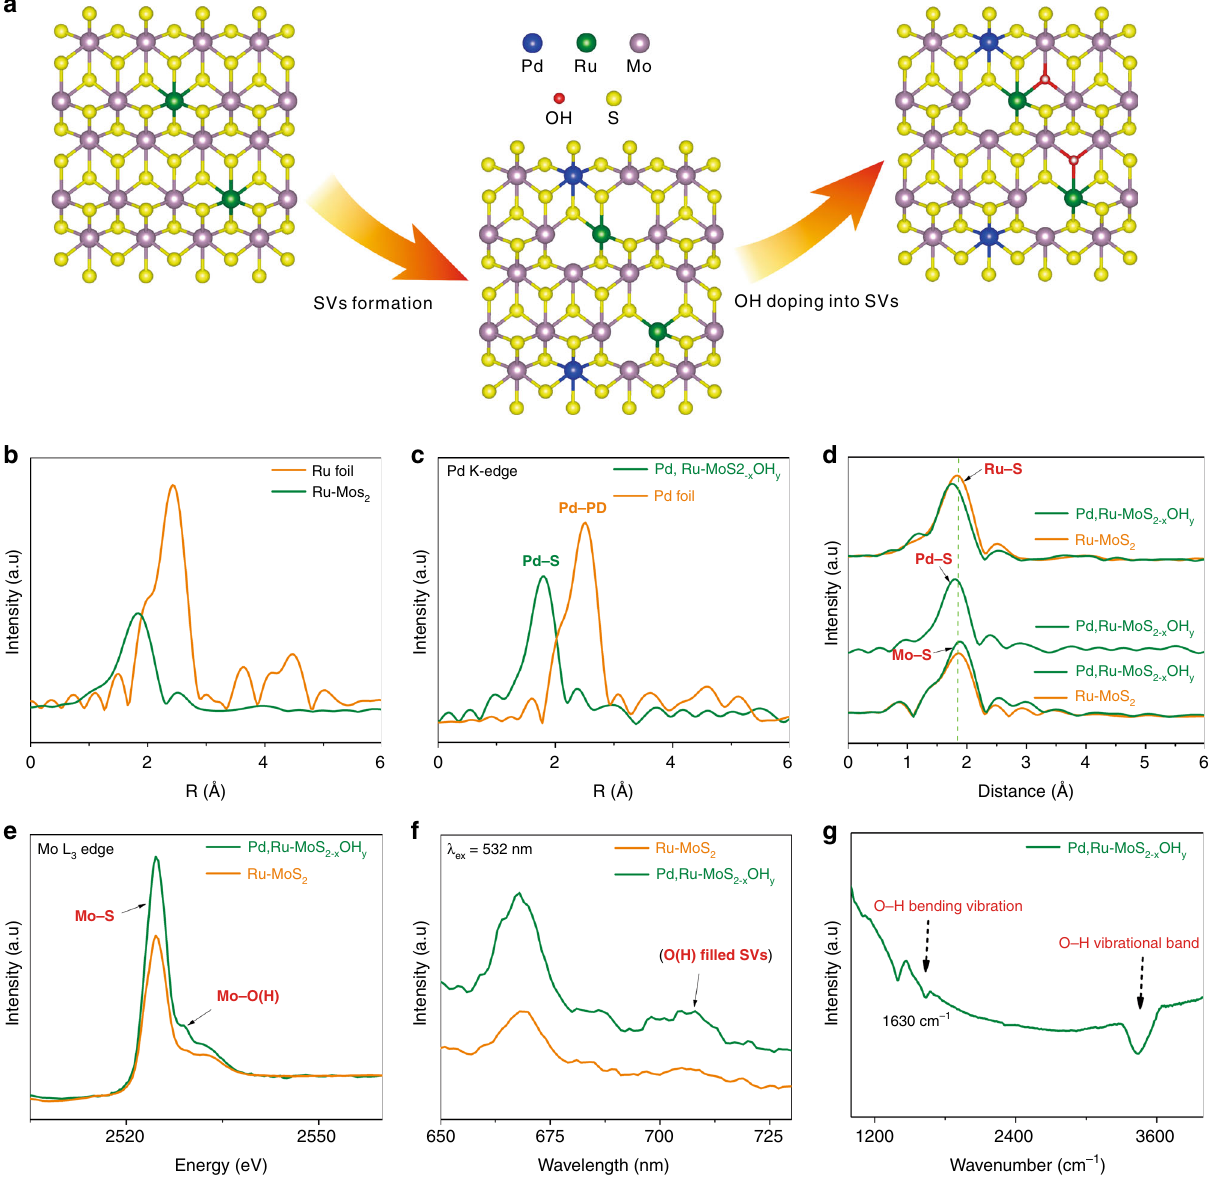
Fig. 1 Schematics for the O fi lled S vacancies (SVs). a Schematics for the synthesis strategy of Pd, Ru dual-doped MoS 2 – x OH y phase. Blue, yellow, purple, green and red spheres represent Pd, S, Mo, Ru, and O atoms, respectively. b Fourier transform of the k 2 -weighted Ru K-edge EXAFS spectra. c Fourier transform of the k 2 -weighted Pd K-edge of EXAFS spectra. d Fourier transform of the k 2 -weighted Pd K-edge, Ru K-edge and Mo K-edge EXAFS spectra. e Mo L 3 -edge XANES spectra of Ru-MoS 2 and Pd, Ru-MoS 2 − x OH y . f Photoluminescence spectra of Ru-MoS 2 and Pd, Ru-MoS 2 − x OH y . g FTIR spectra of Pd, Ru-MoS 2 − x OH y